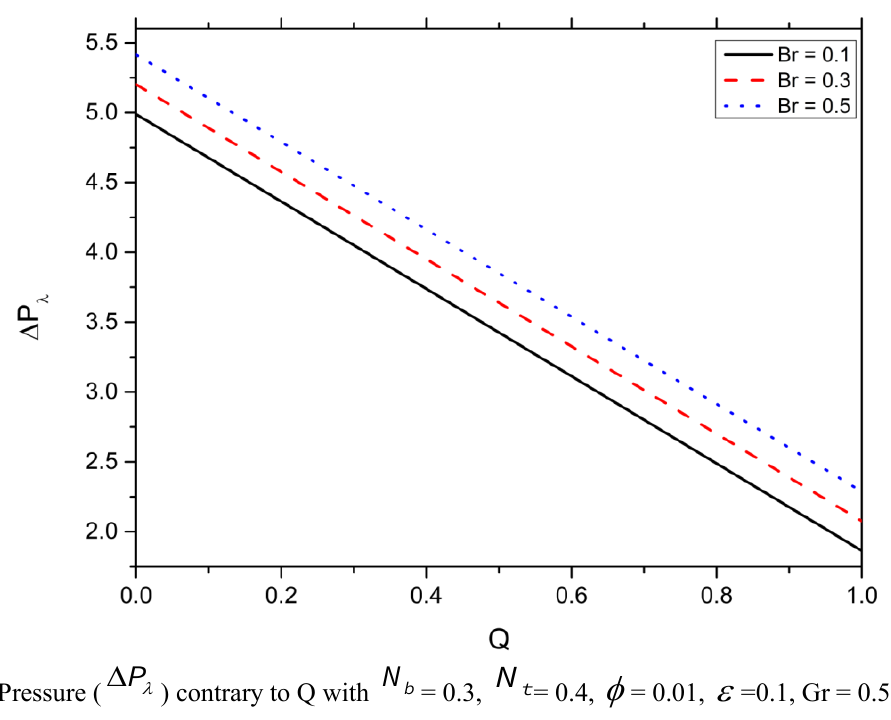
N = 0.3, N = 0.4,  = 0.01,  =0.1, Gr = 0.5, z = 0.5, b t  = 0.01, F = 0.1. Br = 0.3, 1